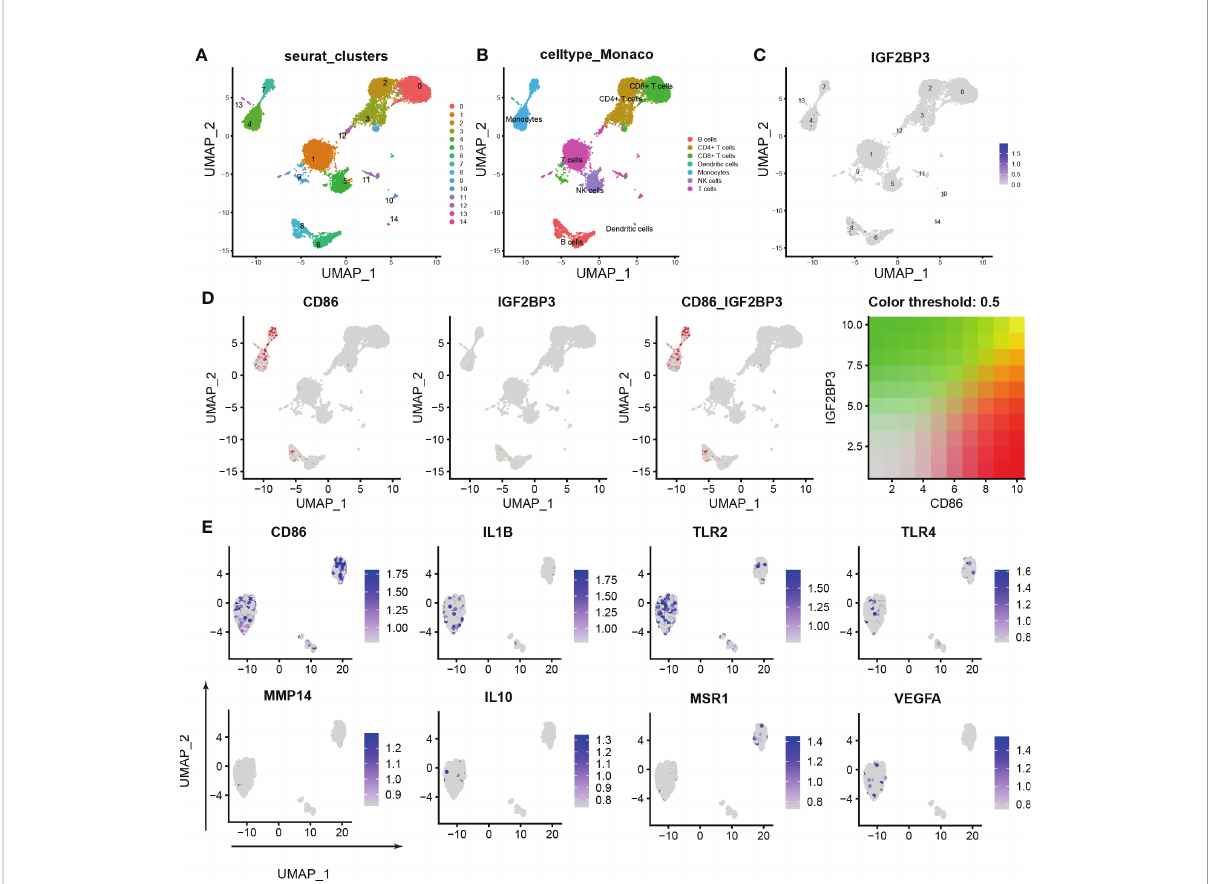
FIGURE 6 Characterization of macrophages by scRNA-seq in PBMCs. (A) UMAP plot showing the sources of the collected scRNA-seq cell samples; (B) UMAP plot showing 14 cell clusters of 7 cell types in the collected samples; (C) UMAP plot showing the IGF2BP3 expression level in the 14 cell clusters; (D) scRNA-seq analysis revealed the correlation between IGF2BP3 and CD86 expression; (E) UMAP plot showing the expression levels of M1 and M2 macrophage